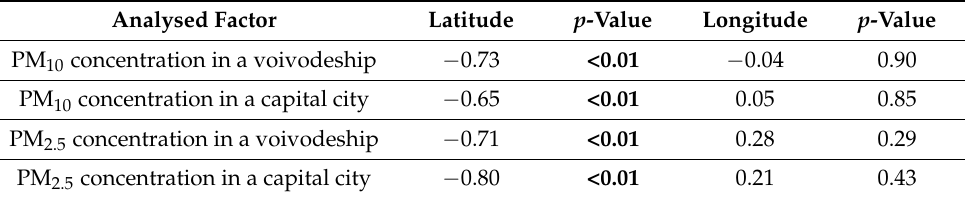
Table 4. Pearson product-moment correlation coefficients for correlations between geographic coor- dinates of capital cities of voivodeships and corresponding particulate matter concentration changes. Analysed Factor Latitude p -Value Longitude p -Value PM 10 concentration in a voivodeship − 0.73 <0.01 − 0.04 0.90 PM 10 concentration in a capital city − 0.65 <0.01 0.05 0.85 PM 2.5 concentration in a voivodeship − 0.71 <0.01 0.28 0.29 PM 2.5 concentration in a capital city − 0.80 <0.01 0.21